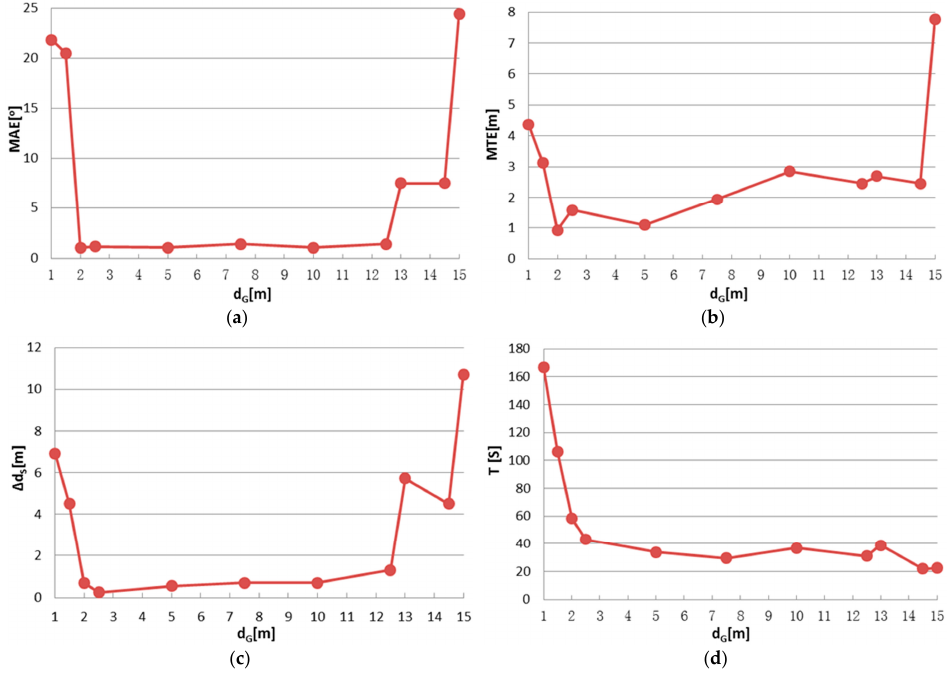
Figure 8. IME results with different d G , when t G is fixed to 10 m: ( a ) mean angular error (MAE); ( b ) translation error (MTE); ( c ) scan distance error ( ∆ d S ); and ( d ) runtime (T).